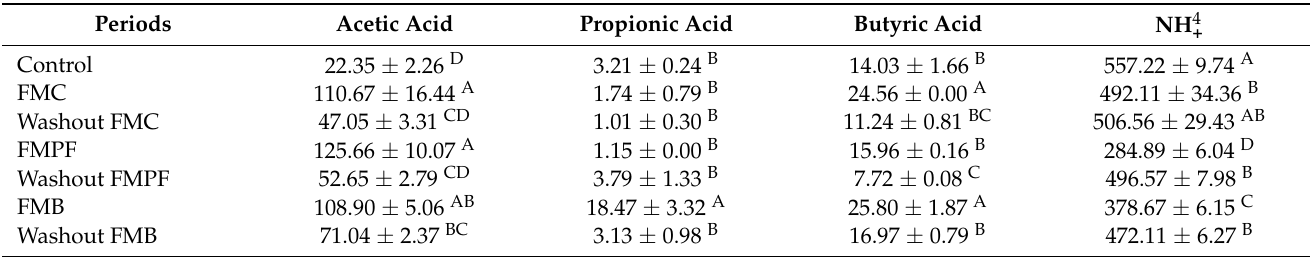
Table 4. Short chain fatty acid levels and ammonium ion (mmol/L) in the vessels corresponding to the ascending colon during the experimental